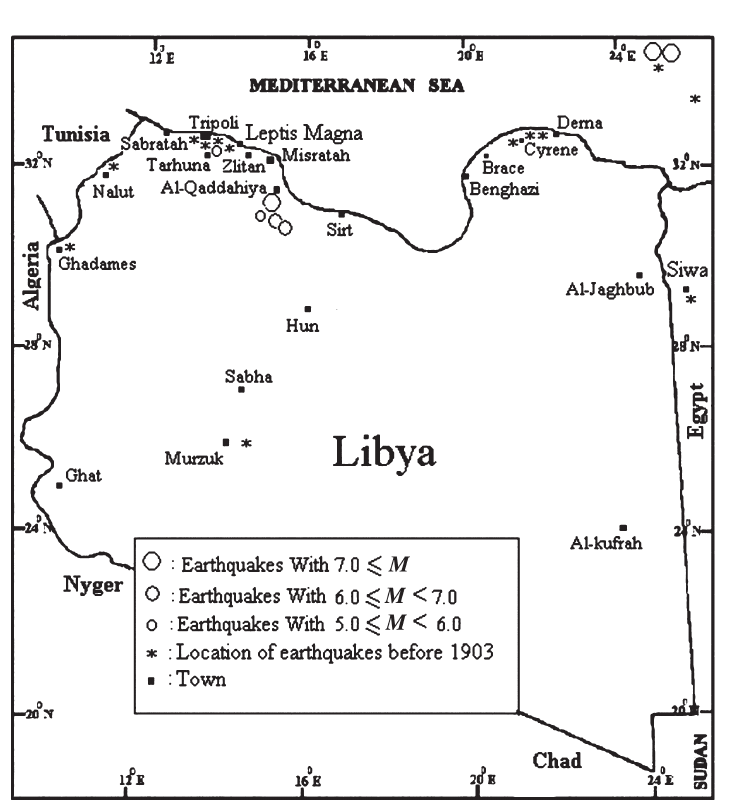
Fig. 1. Seismicity of Libya from the Antiquity to 1935. Note that the city of Brace is today Al-Maraj and Cyrene is today